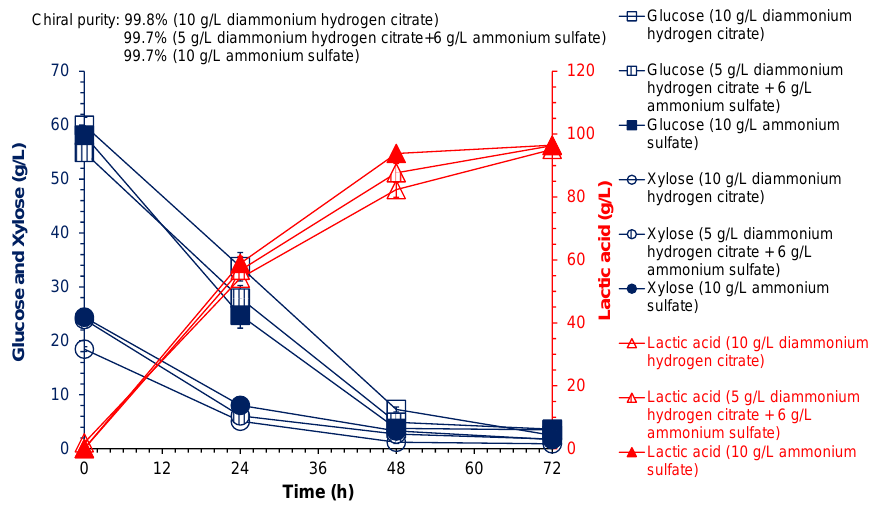
Figure 3. L-lactic acid SSCF using sulfuric acid-hydrolyzed cottonseed meal as complex nitrogen, adding different concentrations of diammonium hydrogen citrate and ammonium sulfate. Conditions: 25% ( w / w )-solids loading: 42 °C, 150 rpm, 72 h. The fermentation pH was controlled at 5.5 by automatically adding a 25% ( w / w ) Ca(OH) 2 solution. Other fermentation nutrients included 20 g/L of cottonseed meal hydrolyzed by 5% ( w / w ) sulfuric acid, and 0.25 g/L of manganous sulfate